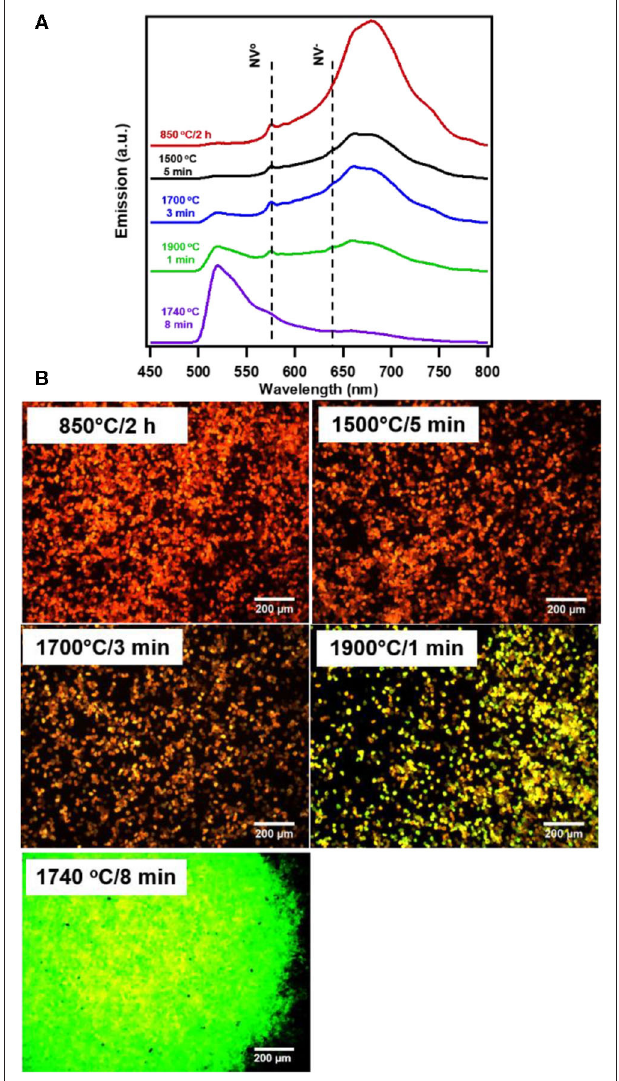
FIGURE 1 | Fluorescence (A) spectra and (B) images of irradiated and typically annealed (850 ◦ C) as well as RTA treated 20 um HPHT diamond particles irradiated to 1.5 × 10 19 e/cm 2 fluence. The zero phonon lines for NV ◦ and NV − are indicated with a dotted line. Spectra and images were taken from bulk collection of particles under broadband illumination at 10x magnification (470/28nm excitation and 488nm long pass emission); images reflect true color of observed